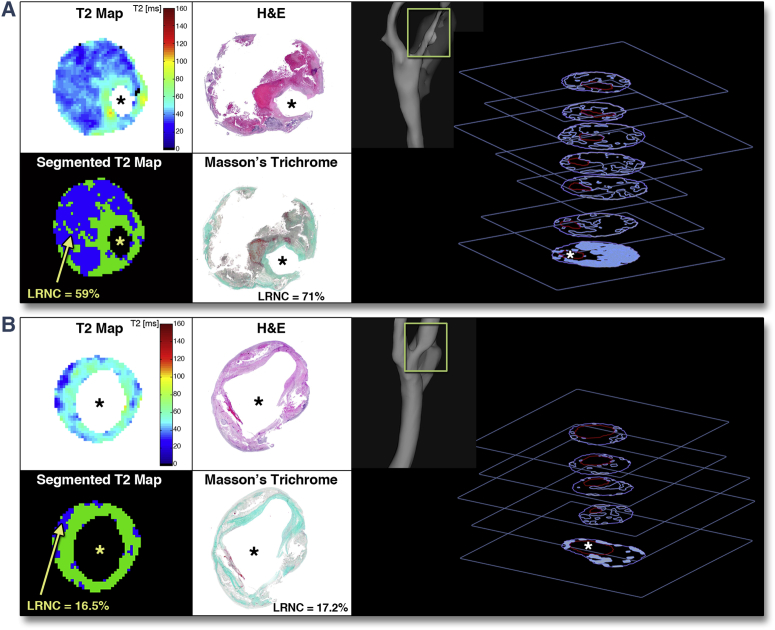
Quantification of Plaque LipidT2 and segmented map of (A) a plaque with large lipid-rich necrotic core (LRNC) and (B) a plaque with multiple smaller lipid-rich pools, and their matching histology. LRNC was segmented from the T2 map by thresholding (voxels with T2 <42 ms or T2 >90 ms). Right panels show 3-dimensional representations of plaque lipid distribution. Stacks of slices show lumen (red) and lipid (blue contours) segmented from T2 maps (for illustration). The * signifies the lumen of the vessel. H&E = hematoxylin and eosin.